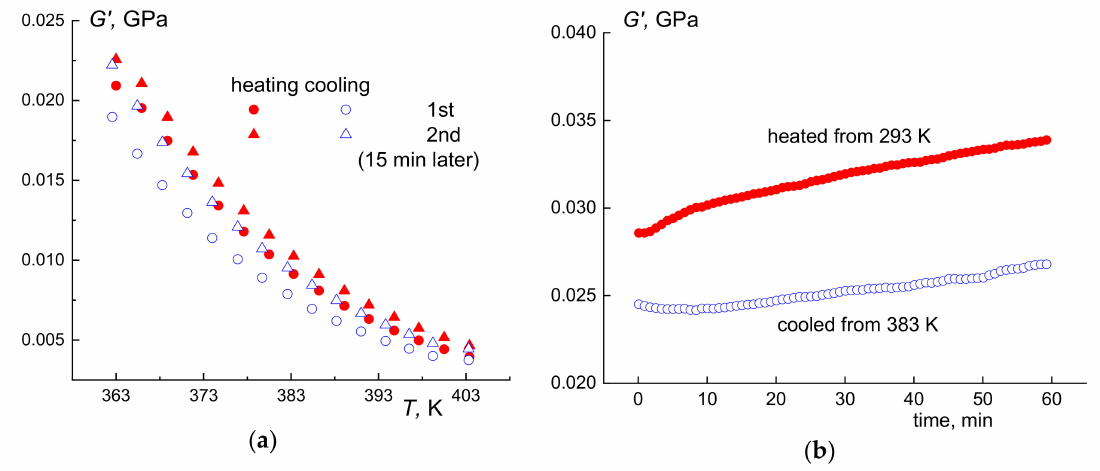
Figure 10. Dependences of the storage modulus, G’, of NB–CDD C1 copolymer on ( a ) temperature in two heating–cooling cycles at 5 K/min and ( b ) time at 359 K measured by oscillatory rheology at 1 Hz with 1% strain. The sample was preheated up to 383 K to erase the thermal